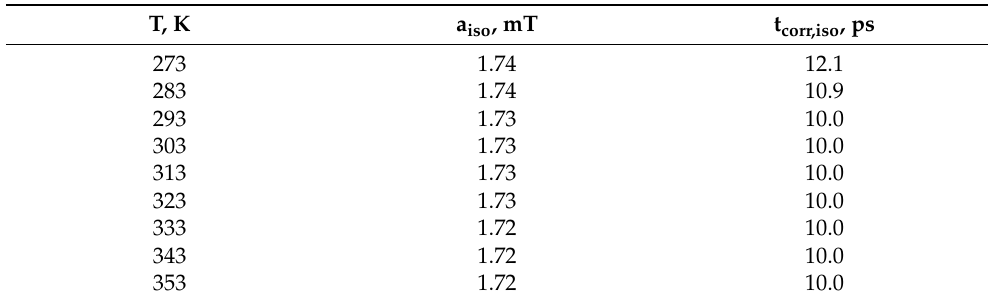
Table A3. Selected spectral parameters from simulation TEMPO EPR spectra in PBS at 273–353